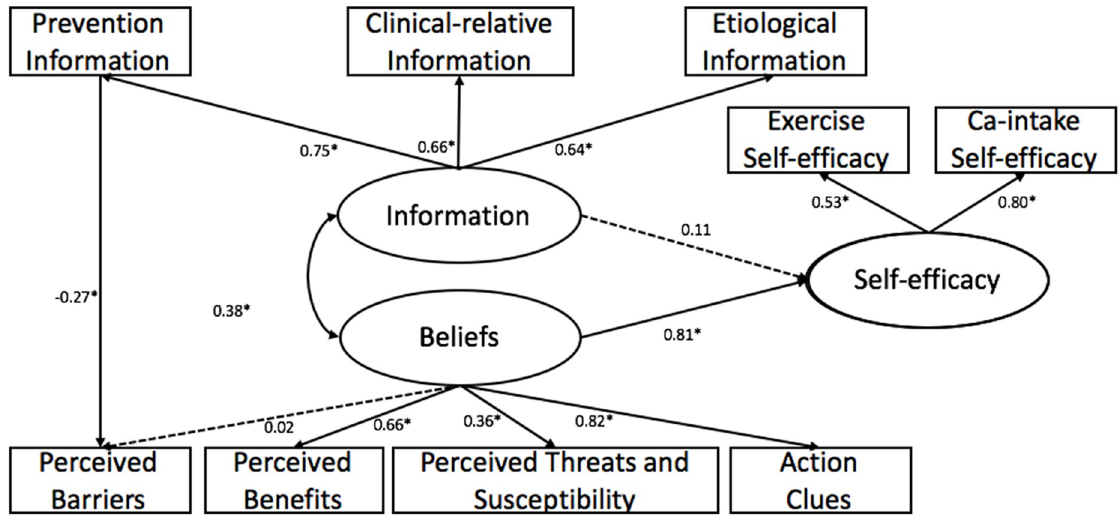
Fig 2. The final confirmatory pathway, predicting self-efficacy among 421 residuals in Shanghai. Oval represent latent variables; rectangle represent observable variables. Single-headed arrow represent regression path, double-headed arrows represent correlations. Dotted line indicates non-significant path from original model. Regression coefficient are standardized ( � p < 0.05).